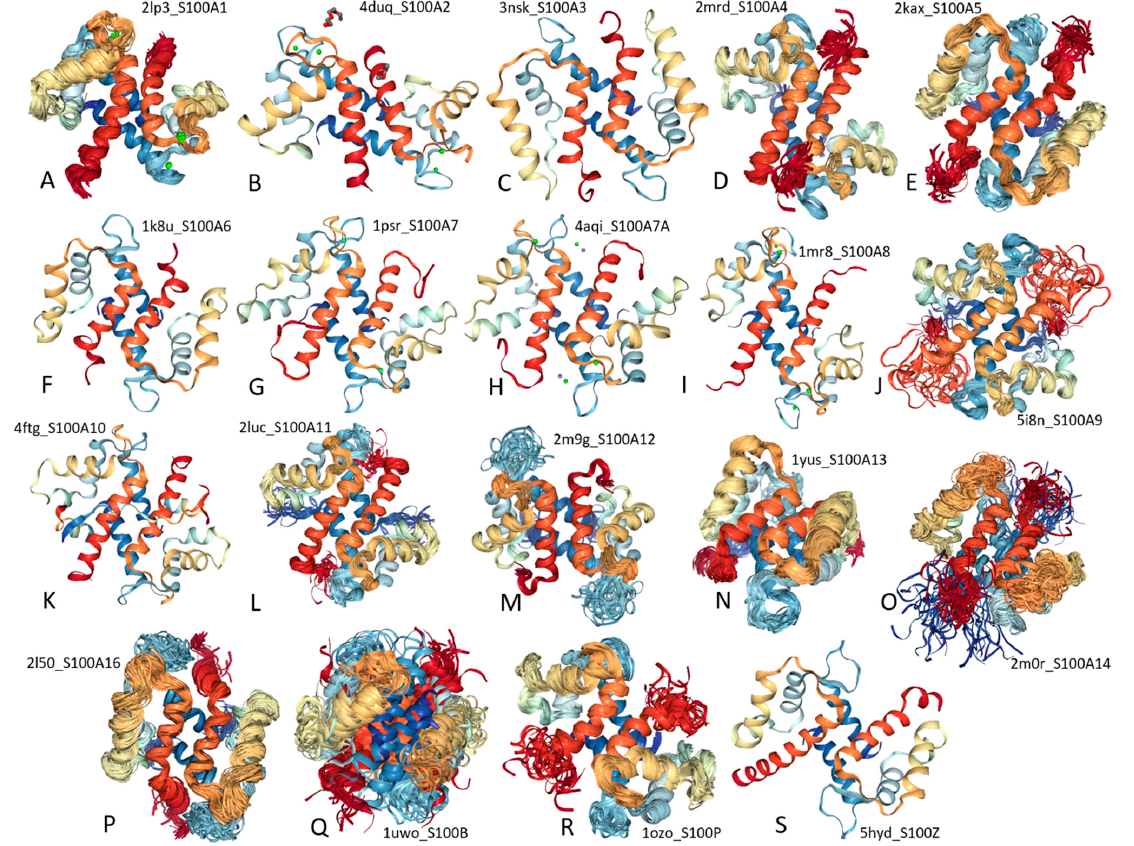
Figure 1. Structural characterization of human S100 proteins. solution NMR structures (plots A , D , E , J , L , M , N , O , P , Q , and R ) or X-ray crystallographic structures (plots B , C , F , G , H , I , K , and S ) are shown for S100-A1 ( A , PDB ID: 2LP3), S100-A2 ( B , PDB ID: 4DUQ), S100-A3 ( C , PDB ID: 3NSK), S100-